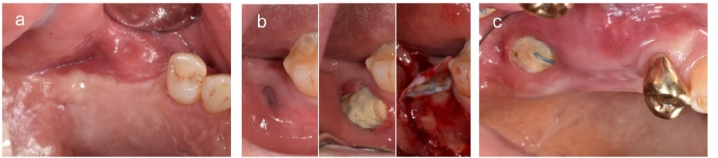
Figure 3. Representative cases. ( a ) No exposure, ( b ) exposure with membrane removal during the healing period, and ( c ) exposure without membrane removal until implant